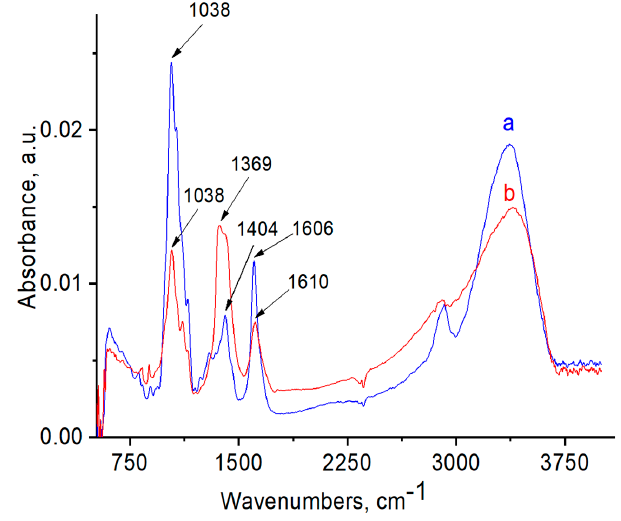
Figure 7. FTIR spectra of gellan ( a ) and gellan-AuNPs ( b ).